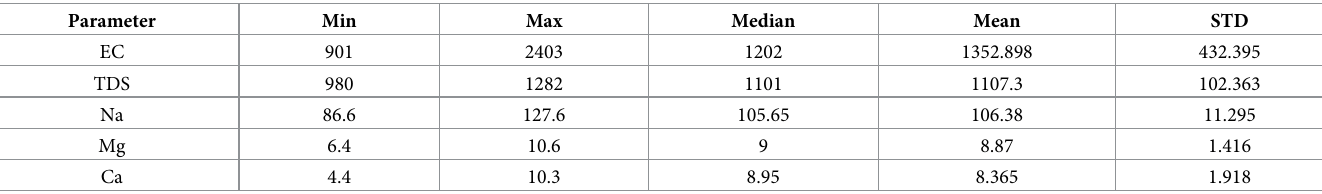
Table 7. Water quality characteristics from 0.5 m column depth